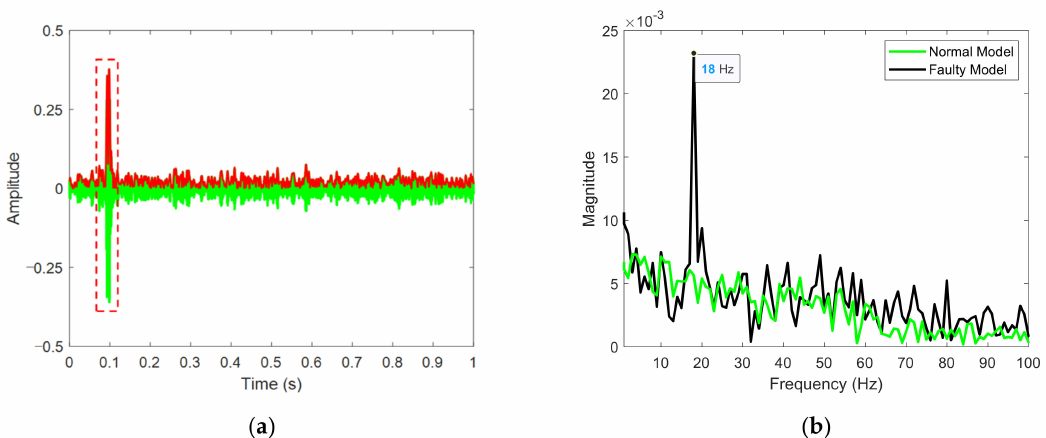
Figure 4. ( a ) Filtered normal signal model with one impulsive noise at around 0.1 s. ( b ) Envelope spectrum of the normal and faulty model with one impulsive noise at around 0.1